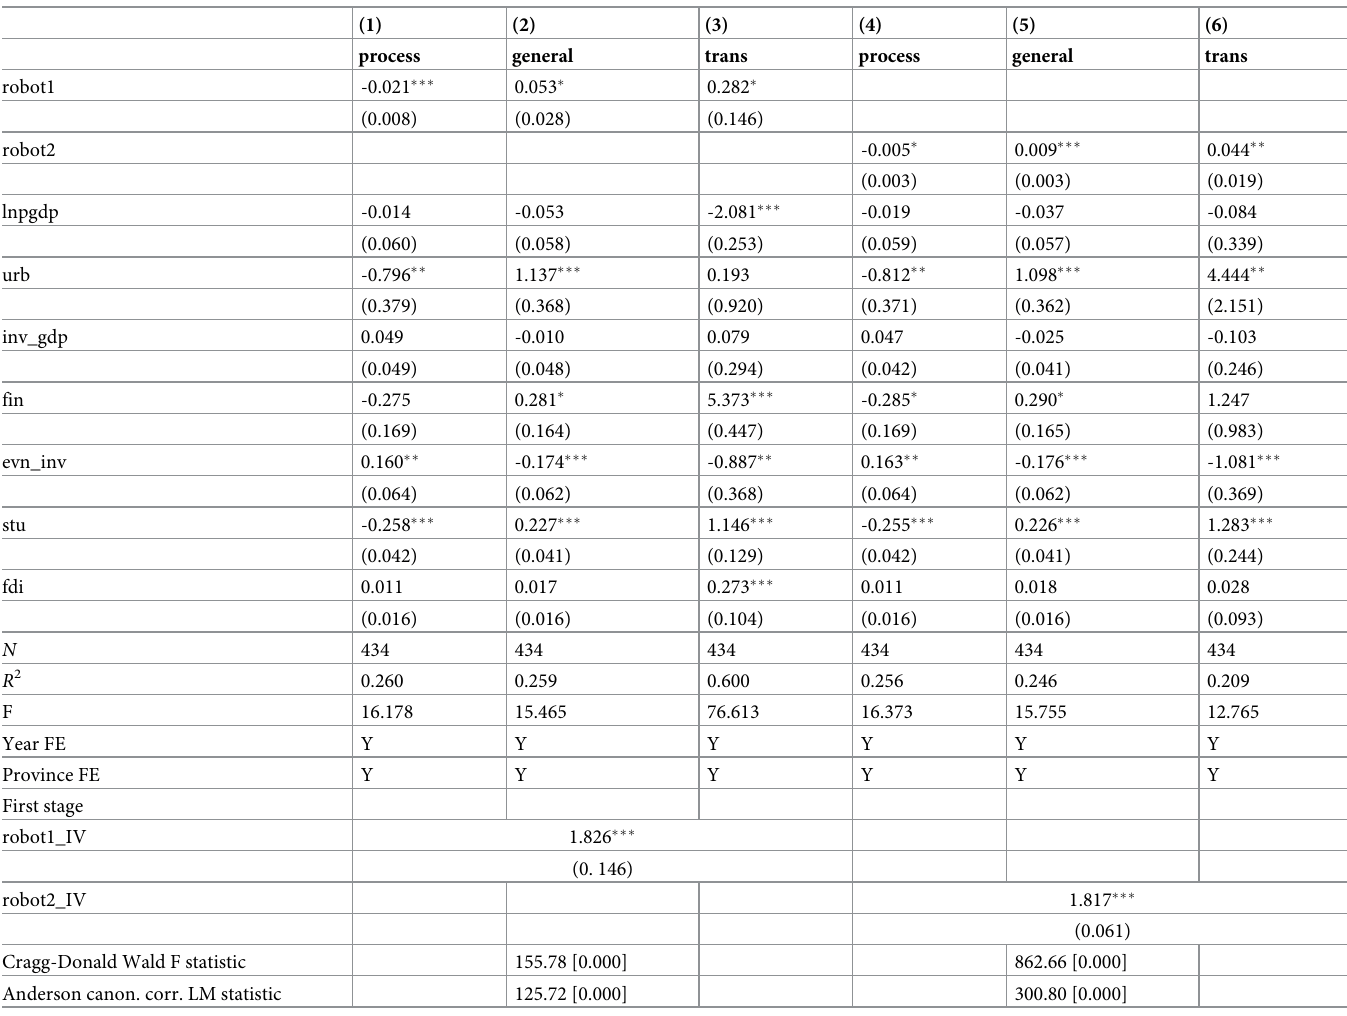
Table 5. Results of instrumental variable